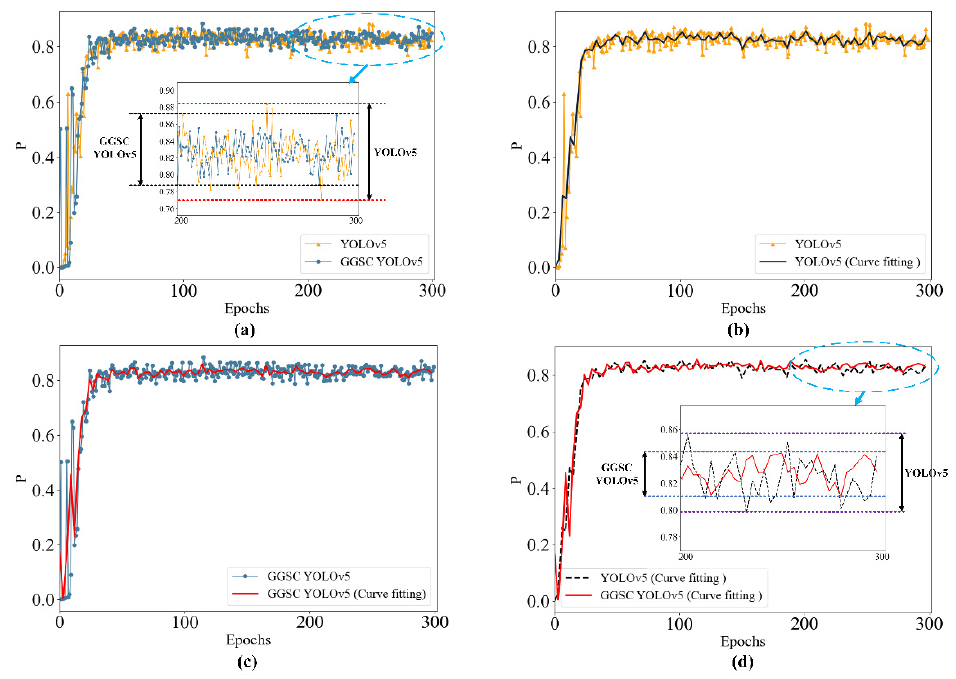
Figure 11. Model precision curve.